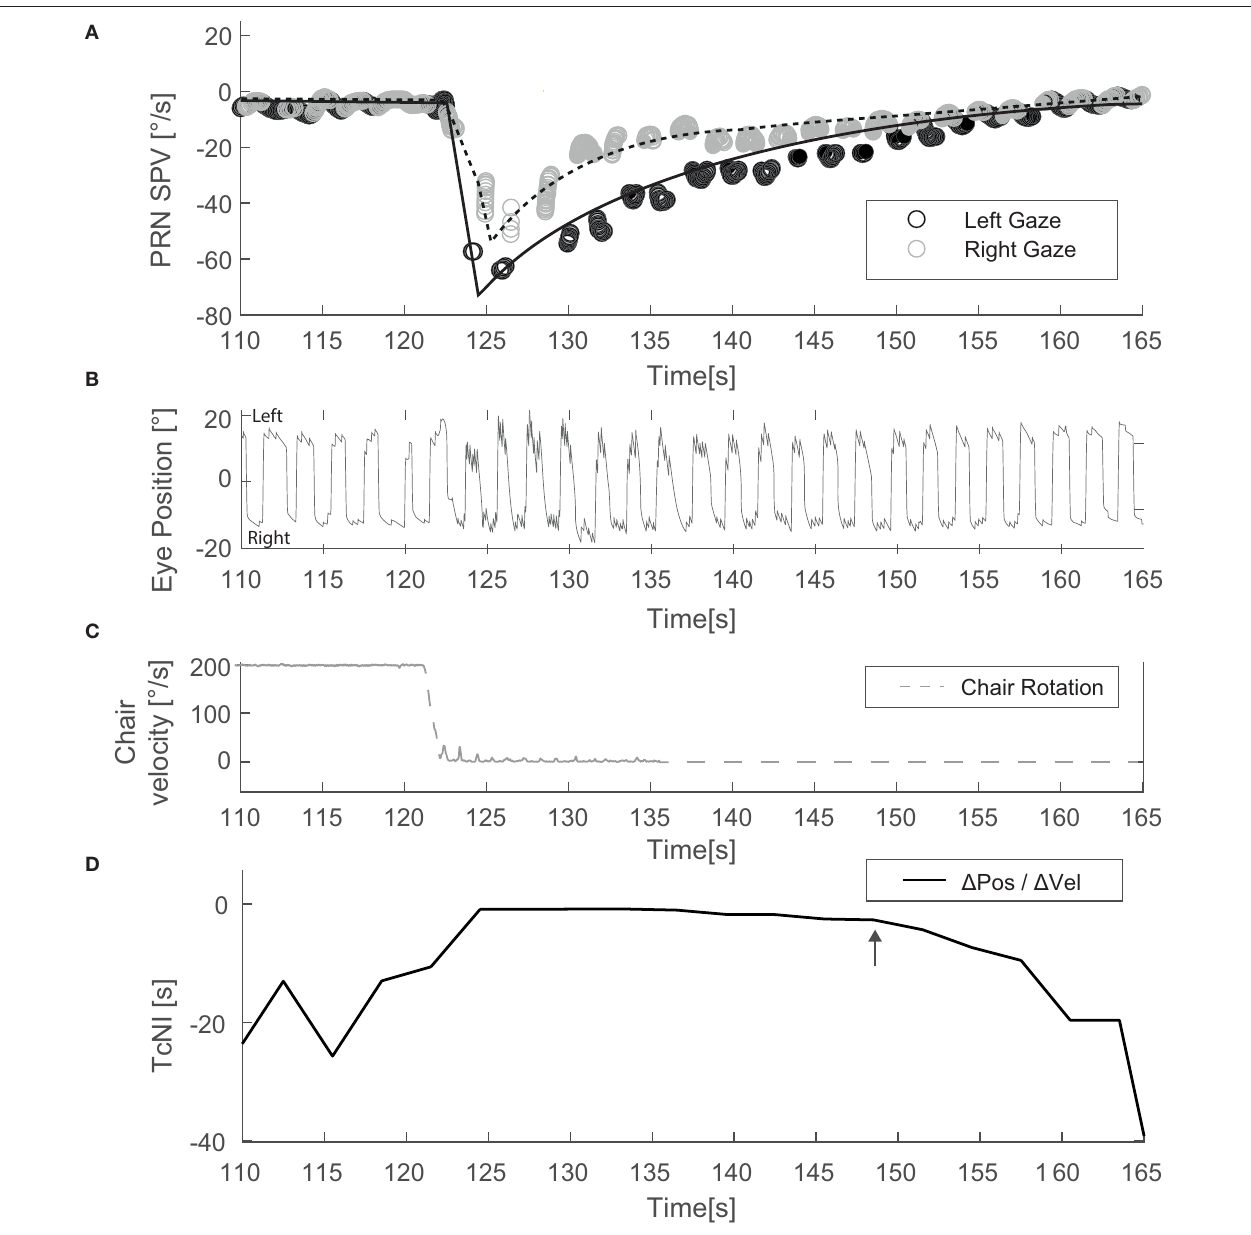
at the same rate. In both paradigms the TcNI was initially decreased and then began to rise again when SPV dropped to comparable values: 21 ◦ /s at 3.5 s after peak velocity for the 100 ◦ /s rotation, vs. 18 ◦ /s at 12 s after peak velocity for the 200 ◦ /s rotation. In other words, the TcNI began to return toward normal when slow-phase velocity decreased to a range of values, rather than at the same time point in the decay of